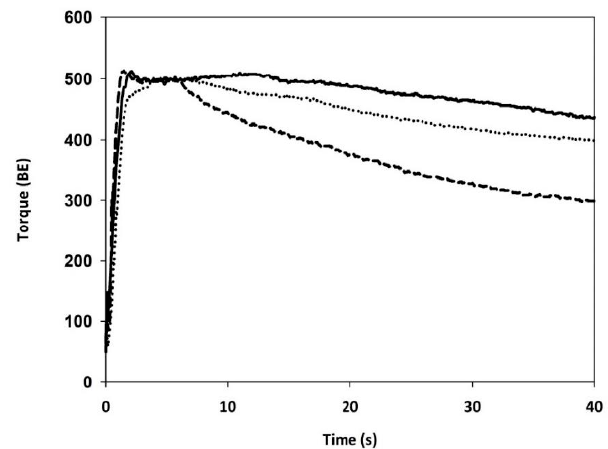
Figure 4. Farinograph profiles of refined wheat flour alone (solid line) and in presence of bran from un-sprouted wheat (dotted line) or bran from sprouted wheat (dash line).